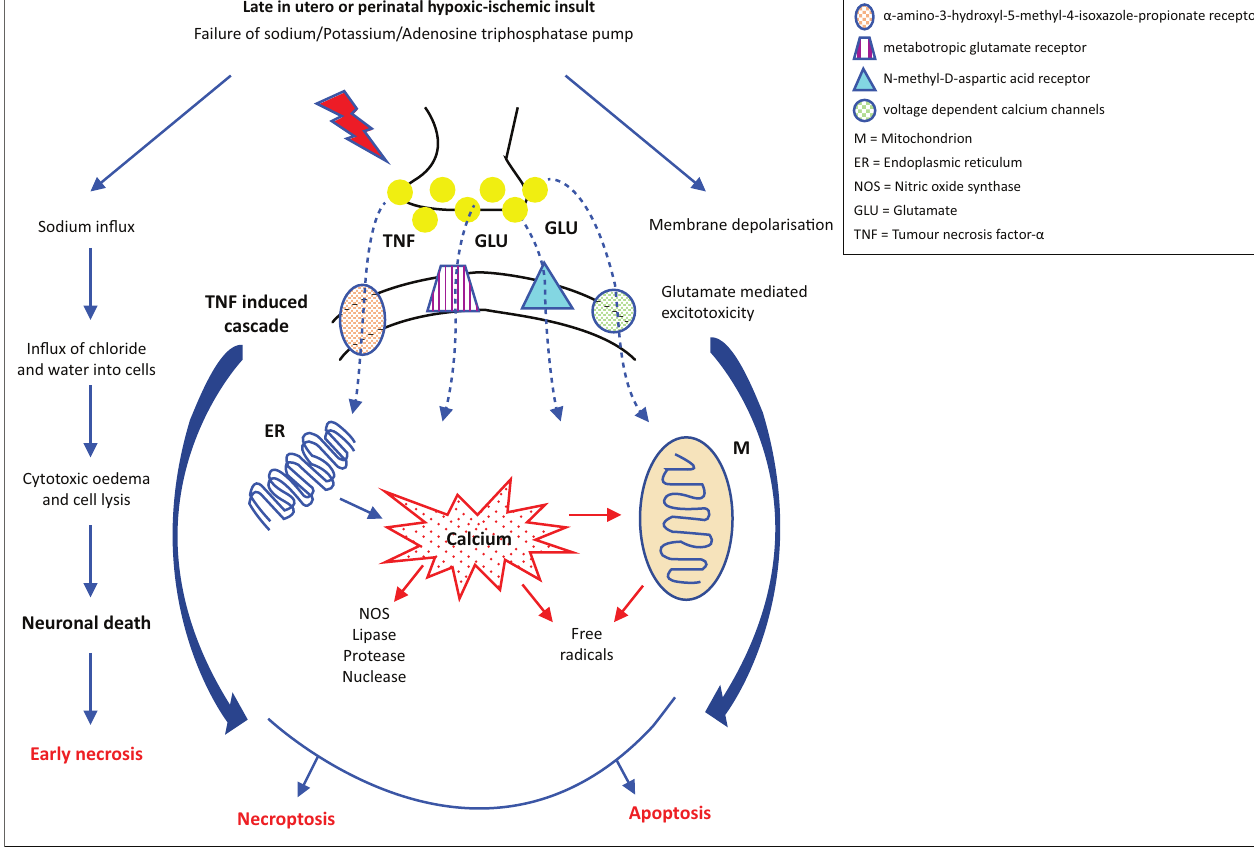
FIGURE 1: Pathogenesis of hypoxic ischemic encephalopathy 12 mediated by sodium potassium adenosine triphosphatase pump failure leading to cytotoxic oedema and early cell necrosis, apoptosis via glutamate-induced excitotoxicity and necroptosis by tumour necrosis factor- α -induced